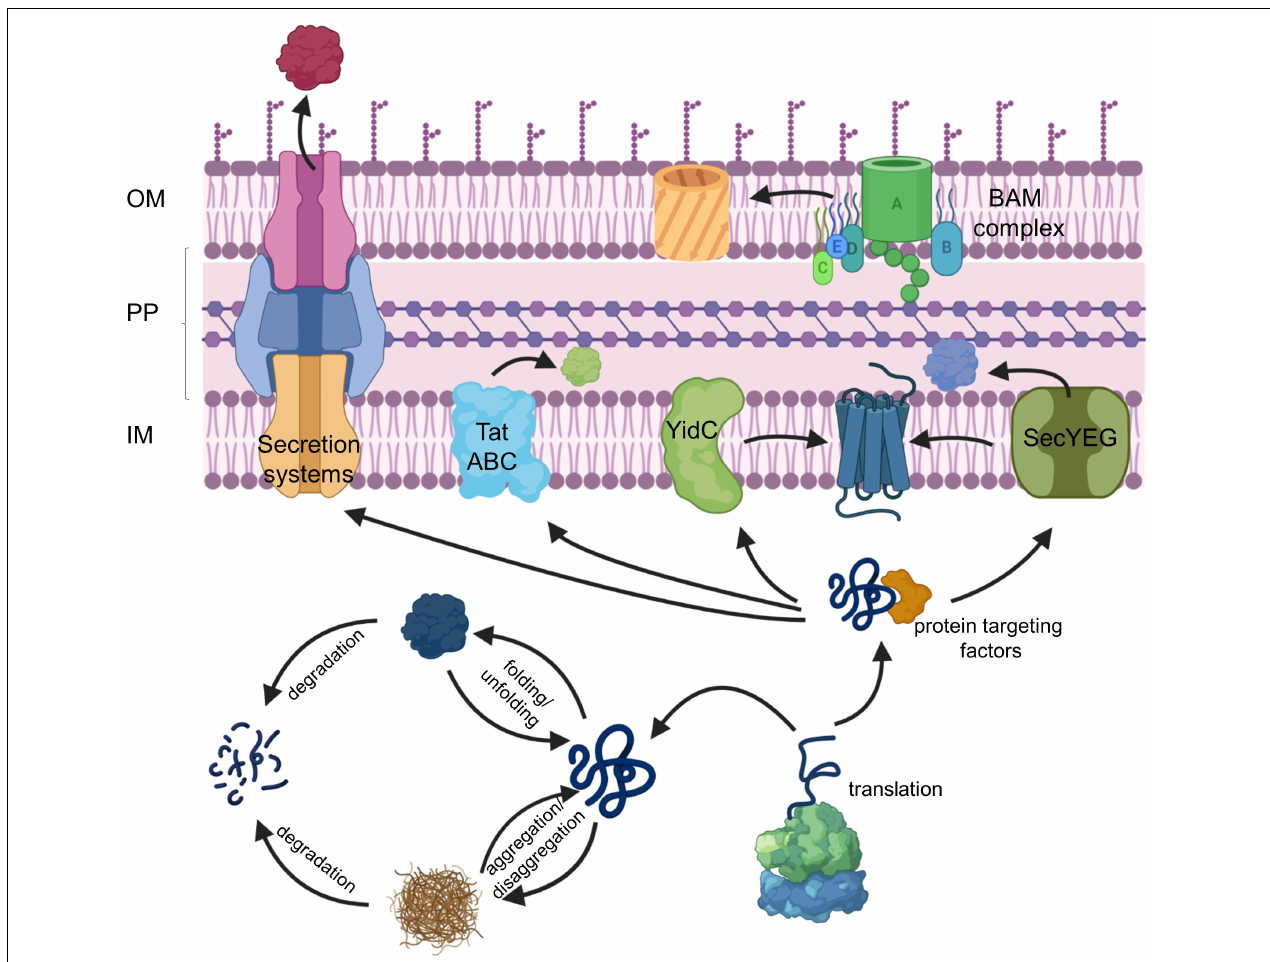
FIGURE 1 | The proteostasis network in bacteria. For details see text. Secretion systems refer to the type I–IX protein secretion systems that have been identified in bacteria, although some of these secretion systems are only found in some species (Christie, 2019). IM, inner membrane; PP, periplasm; OM, outer membrane.